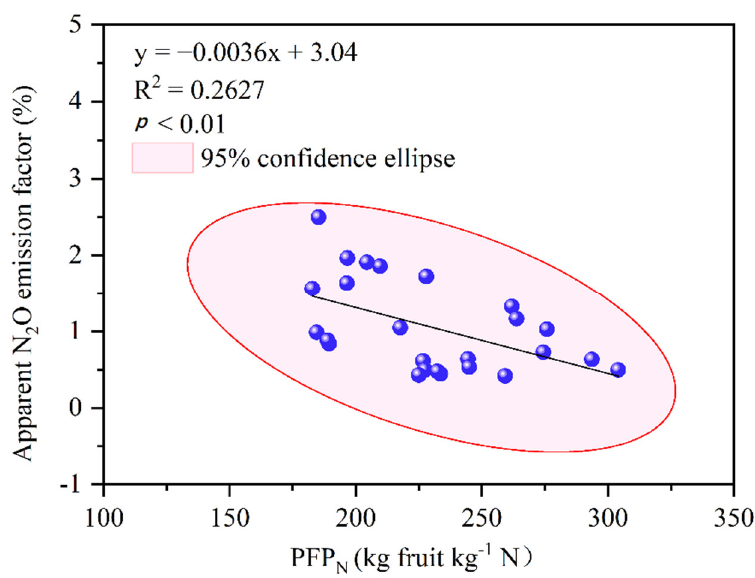
Figure 5. Pearson’s correlation between partial factor productivity of applied N fertilizer (PFP N ) and apparent N 2 O emission factor ( n = 25).